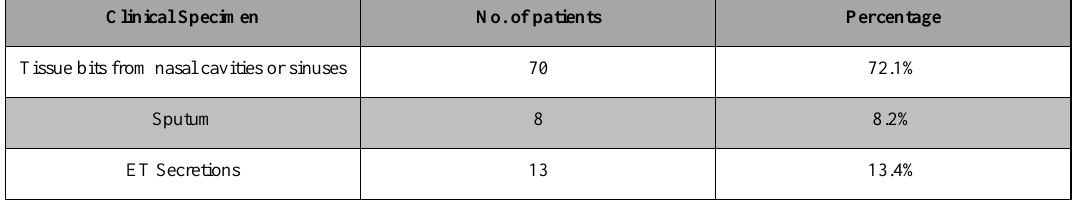
(Table 2). Table 2. Various samples of post-COVID-19 fungal